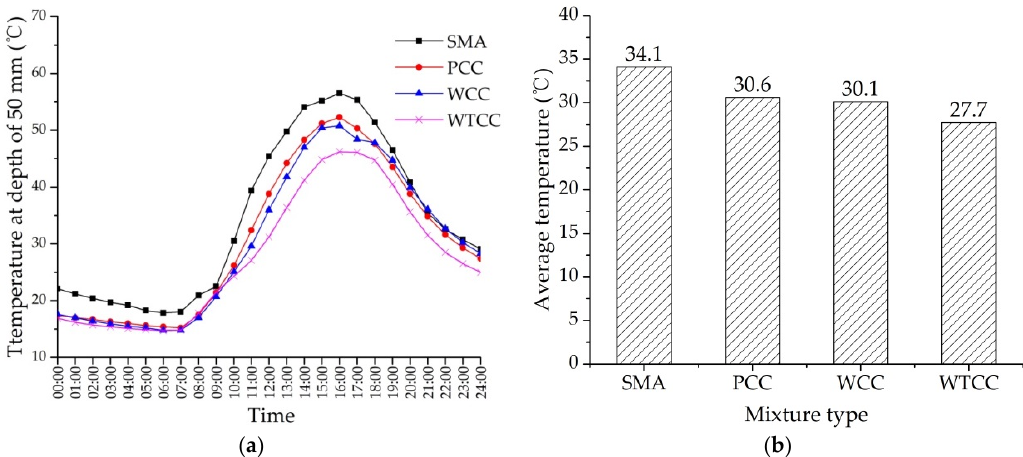
Figure 8. Temperature at the depth of 50 mm under the field air temperature: ( a ) temperature variation curve; ( b ) average temperature.